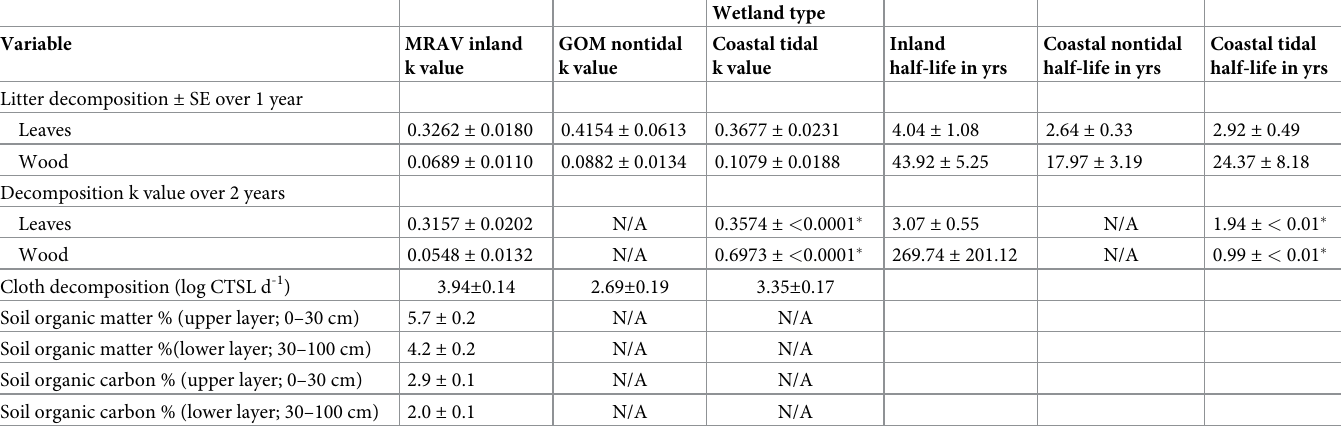
Table 1. Overall means ± SE for the decomposition rates of leaf and wood material after one and two years, half-life (50% turnover time), cloth decomposition rates, and soil organic matter %, and soil organic carbon % in MRAV inland, GOM tidal and GOM non-tidal freshwater Taxodium distichum swamps. Inland swamps were located in the Mississippi River Alluvial Valley from Illinois to Louisiana, and coastal tidal and nontidal from Texas to Florida in the southeastern United States. “N/A” designates that the information is not available. ‘ � ’ is based on one sample bag